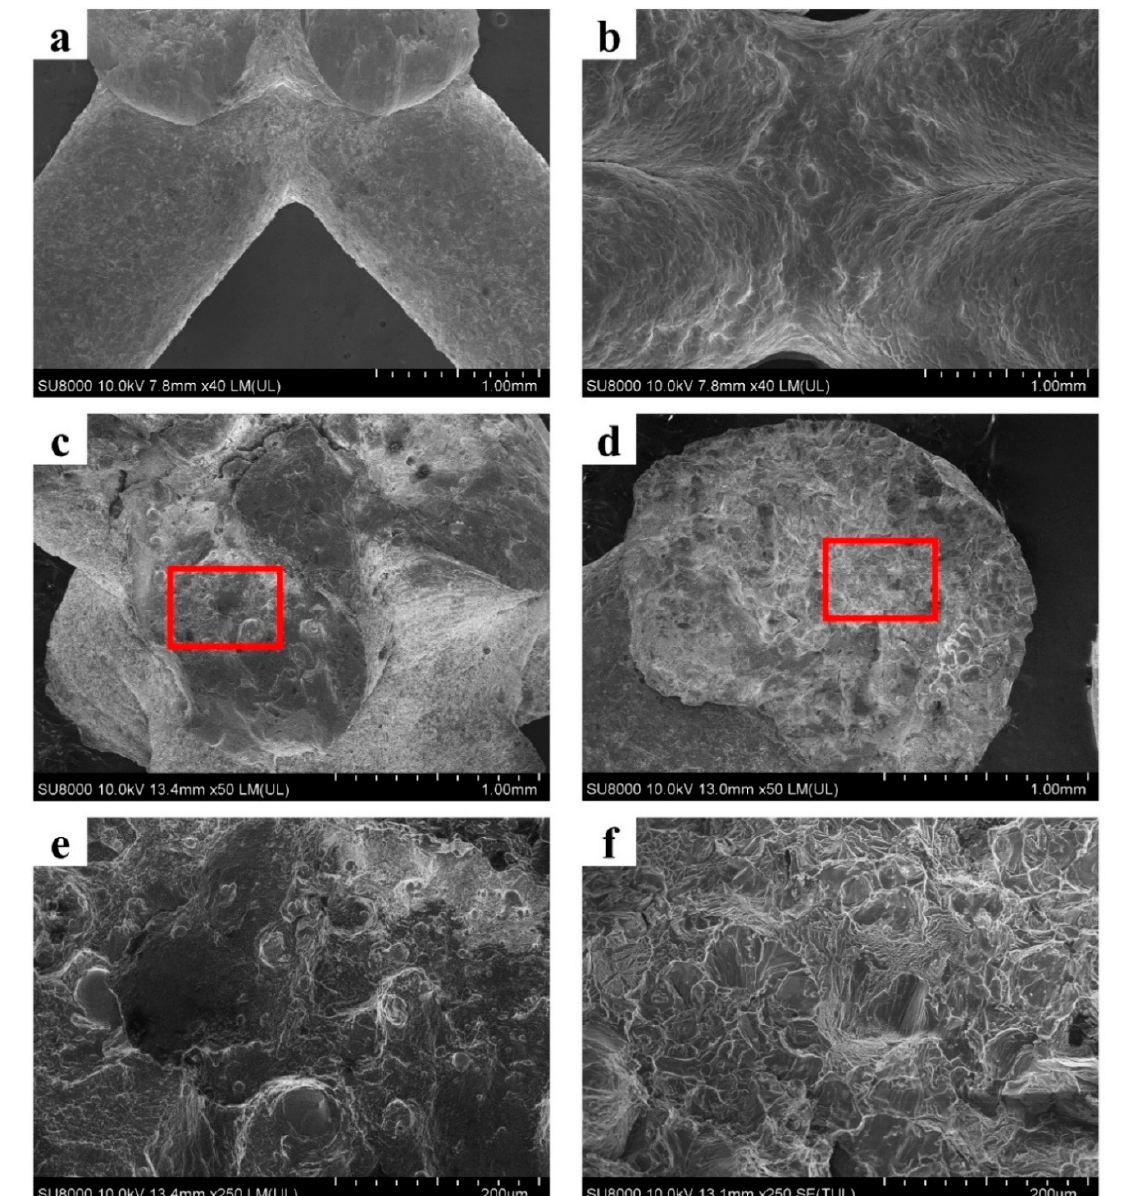
Figure 8. The strut surface morphology of ( a ) AM AlSi10Mg and ( b ) as-cast 7005 Al alloy lattice structures; ( c , d ) are the morphology of fracture surface of AM AlSi10Mg and as-cast 7005 Al alloy lattice structures; ( e , f ) magnified microstructures in the red frames of ( c , d ).